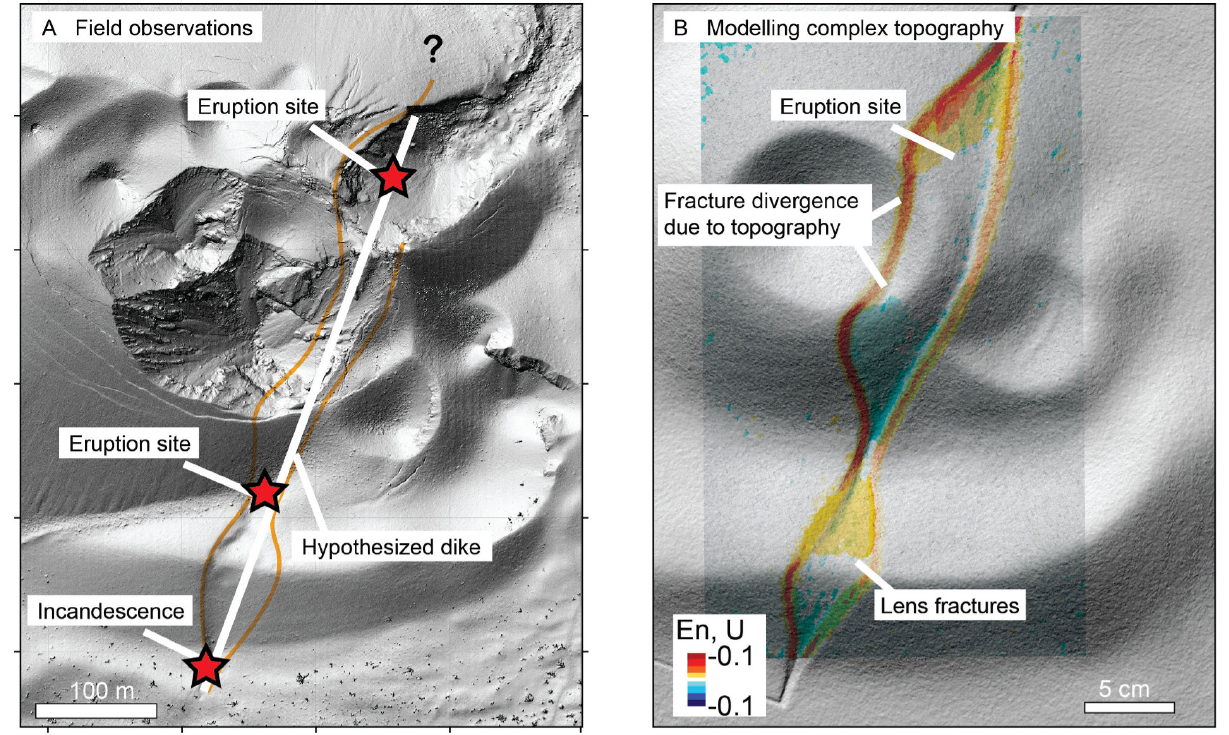
Figure 8: Conceptual model of the late La Palma fracture and complex topography effect. [A] Drone derived high resolution shaded relief map and the tensile fracture (dike) hypothesised in this work, connecting the northern eccentric eruption and the lens shaped fracture in the south. [B] Analogue model with a complex morphology, considering a ridge in the south, and a high cone/crater in the centre, may explain the structures observed. Northern continuation (question mark in [A]) showed multiple short term vents. Color contours show normal strain (En) in the direction perpendicular to the tensile fracture. See discussion section for